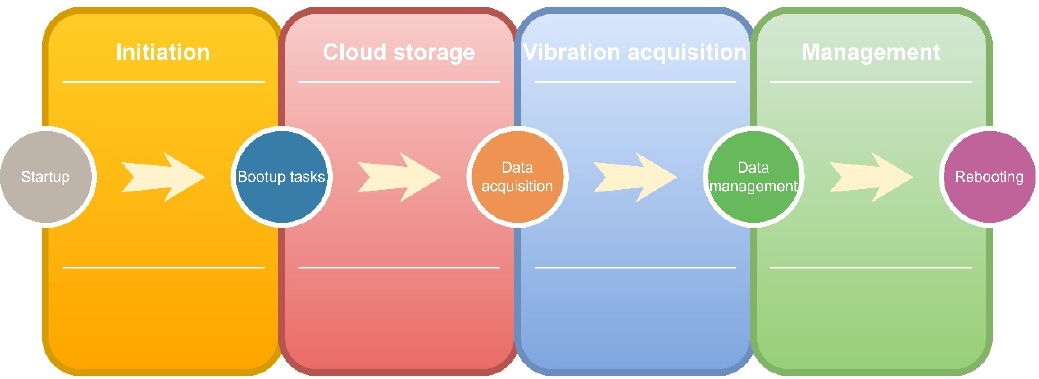
Figure 2. Automation of the data acquisition process of LARA.